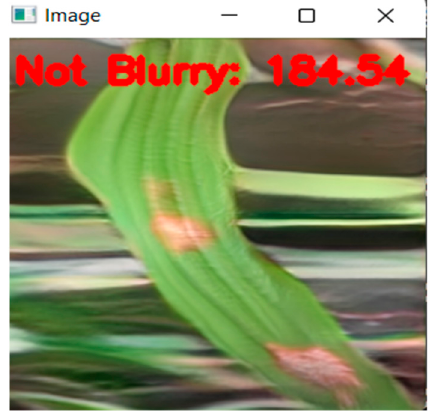
Figure 2. Detected as not blurry image.